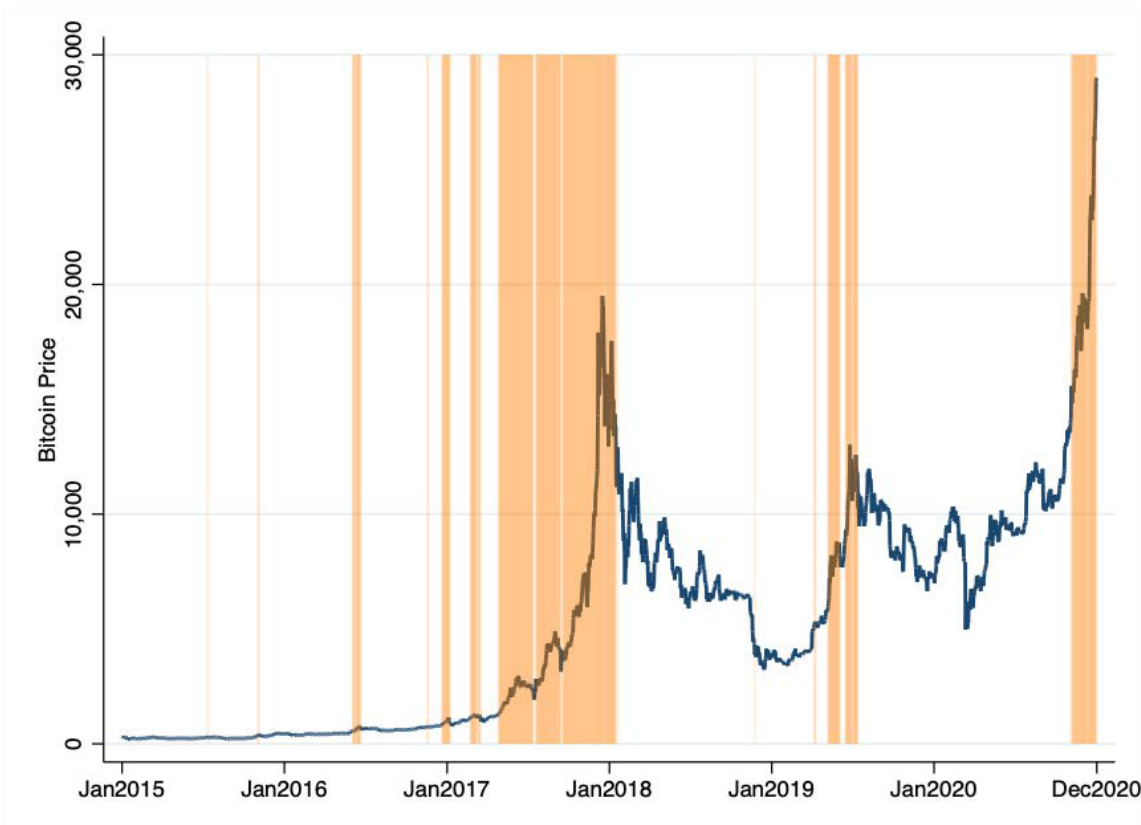
Figure A1. This figure represents the evolution of Bitcoin price and bubble periods between 1 January 2020, and 31 December 2020. The solid line is the Bitcoin price, and the shaded areas are the bubble periods (days when the PSY statistic exceeds its 95% bootstrapped critical